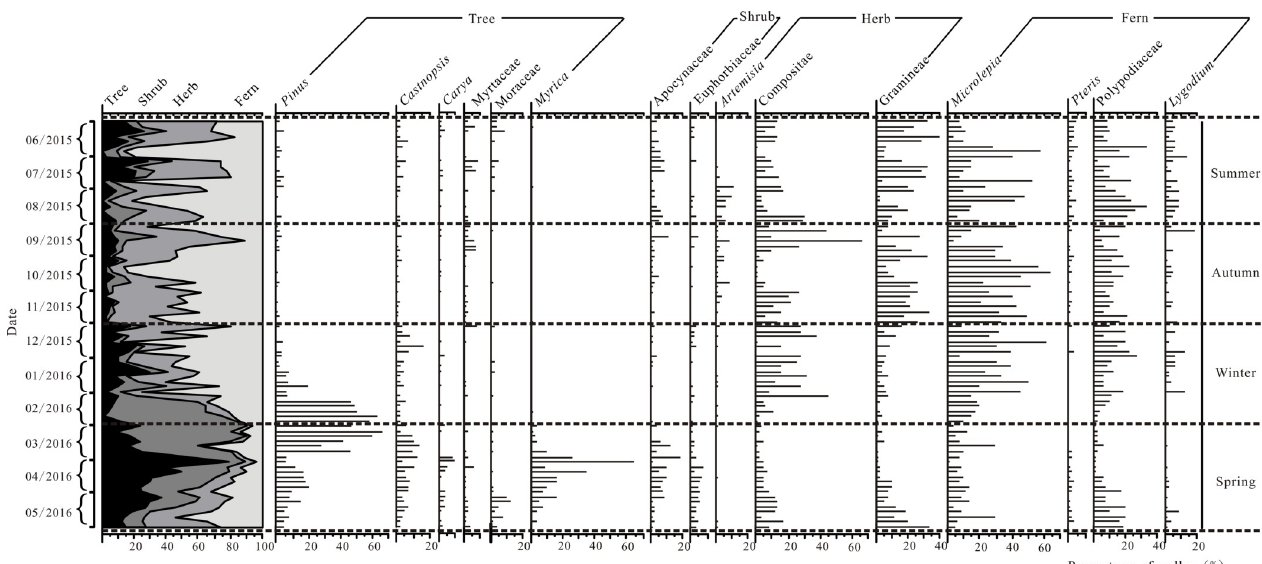
Fig 2. Percentages of airborne pollen in different months in central Zhanjiang city during 2015~2016.